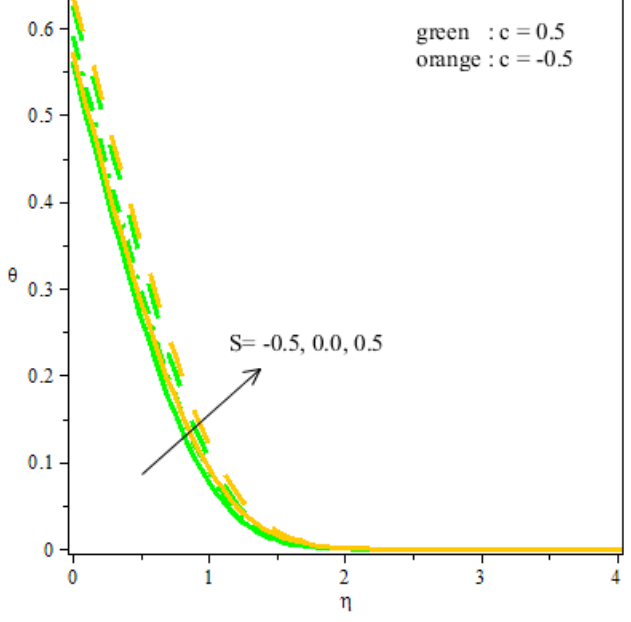
Figure 11. The curve θ ( η ) on S .